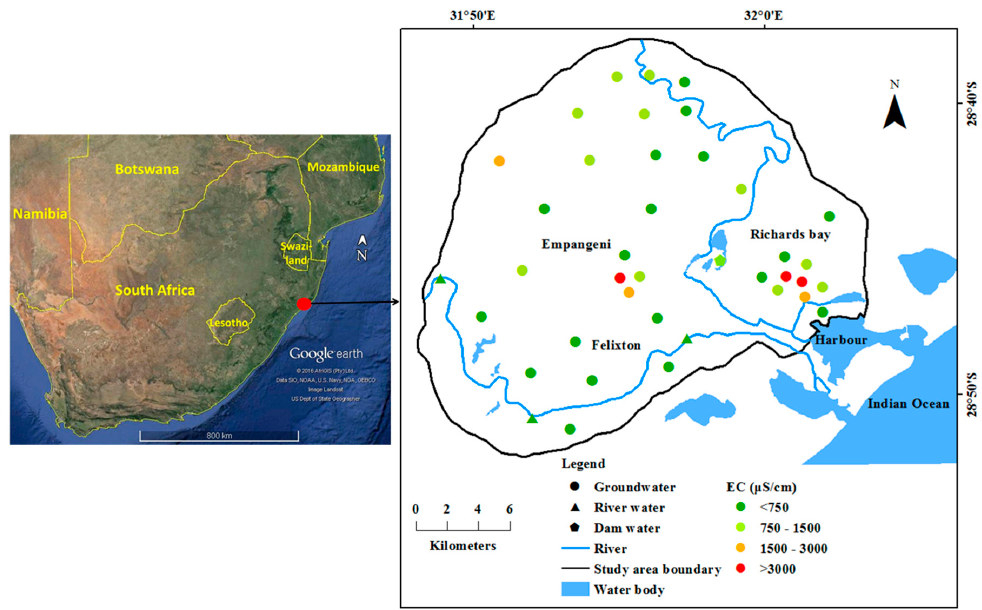
Figure 1. Location of study area and spatial variation in electrical conductivity (EC) of water at monitoring locations.